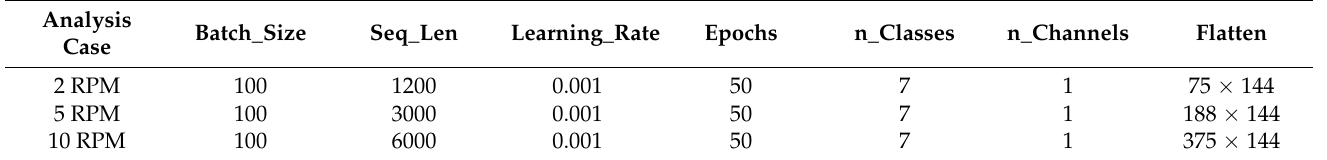
Figure 2. Design and configuration of the proposed 1D-CNN method to detect spindle failures. Table 3. Hyper parameters configuration for the